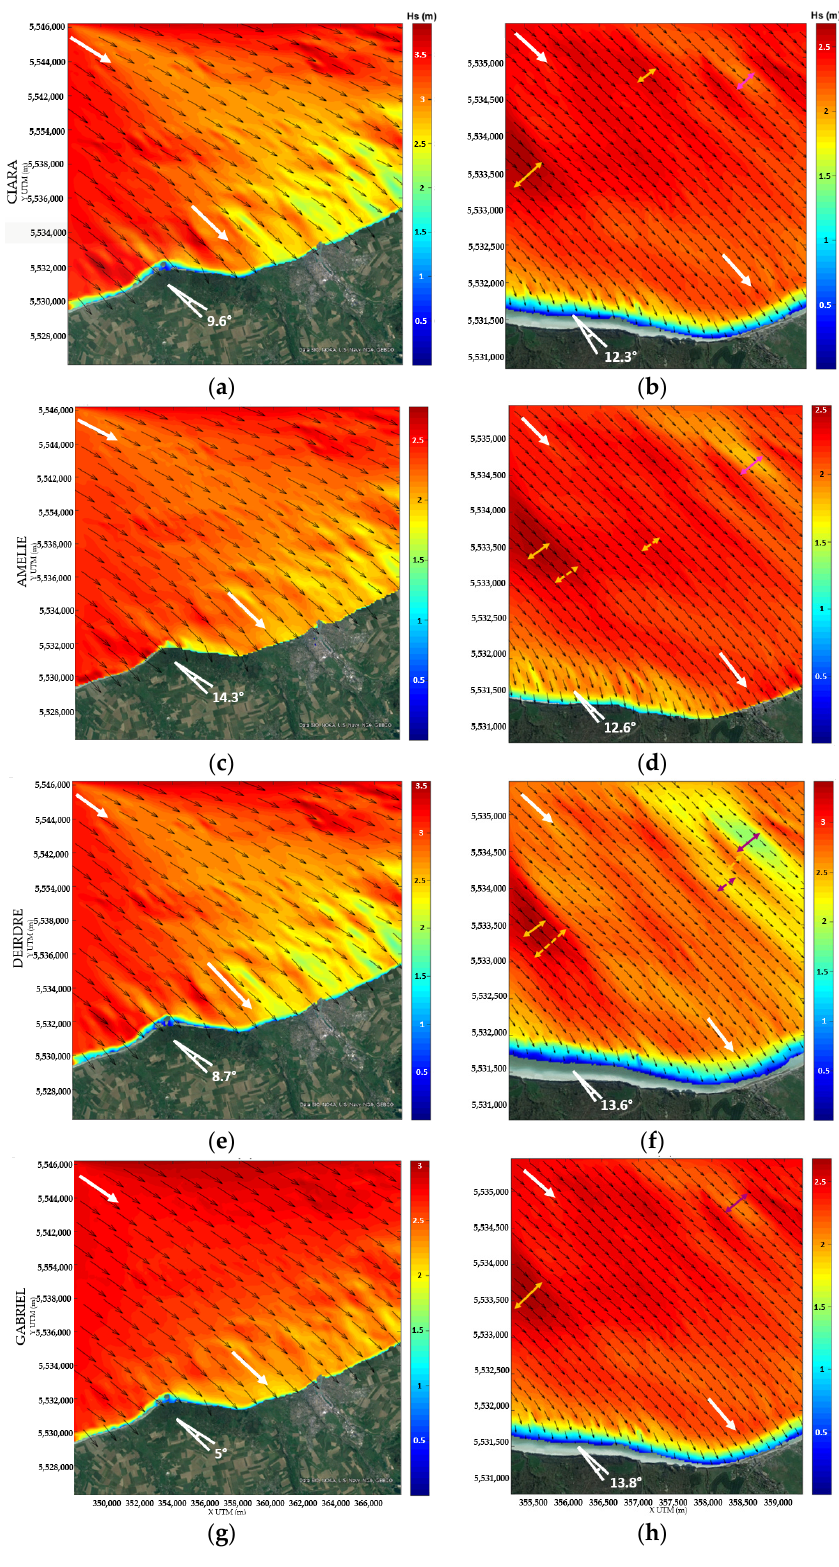
Figure 8. Distribution maps at the peak of the storm of H s and θ in the coarse grid ( a , c , e , g ) and nested grid ( b , d , f , h ) in Etretat for Ciara (February 2020) ( a , b ), Amelie (November 2019) ( c , d ), Deirdre (December 2018) ( e , f ) and Gabriel (January 2019) ( g , h ) storms. White arrows show the refraction of waves when approaching to